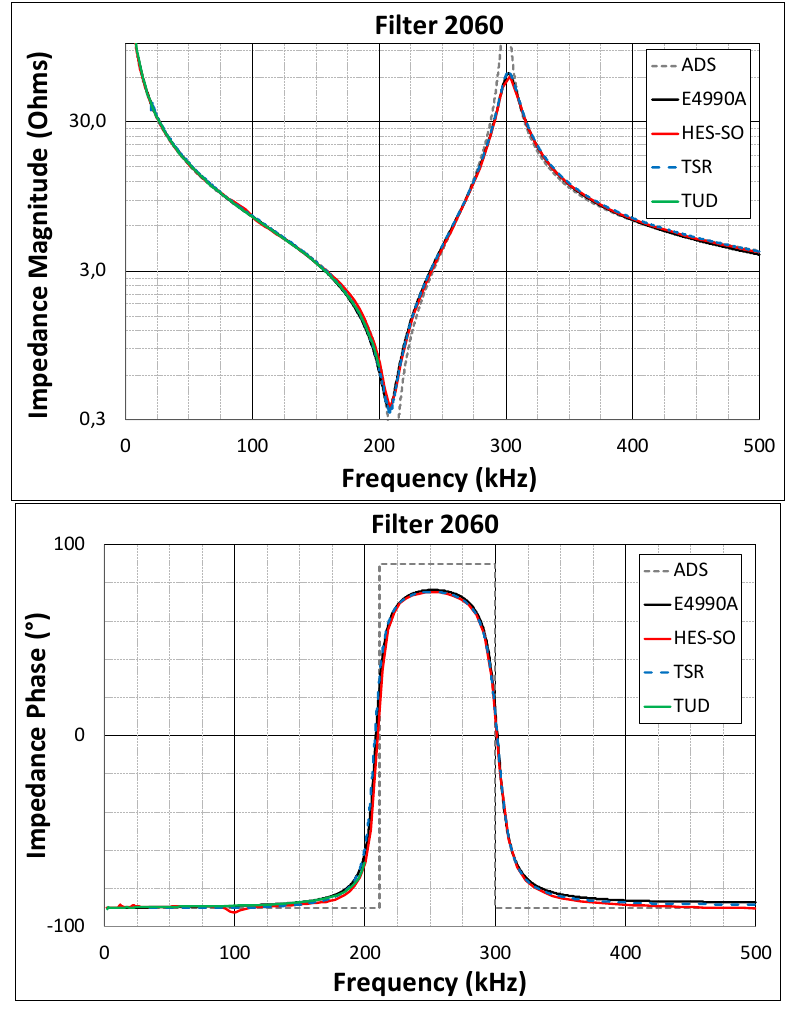
Figure 8. Comparison of simulations and measurement results for filter Reference 2060: (up) magnitude, (down) phase of the